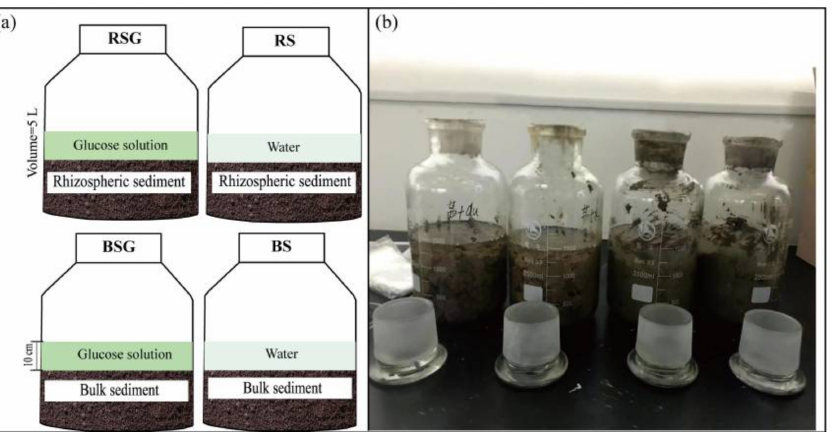
Figure 1. Diagram of the four constructed wetland pots. Image ( a ) shows the variables, and ( b ) shows the scene